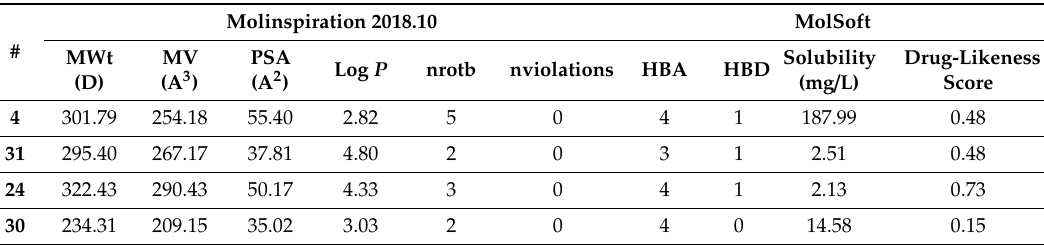
Table 3. In silico ADME pharmacokinetics